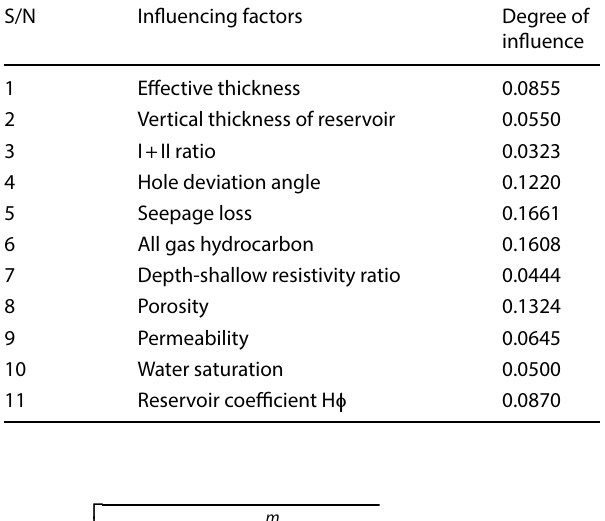
Table 1 Influences of main control factors in Deng-4 member of highly deviated/horizontal wells S/N Influencing